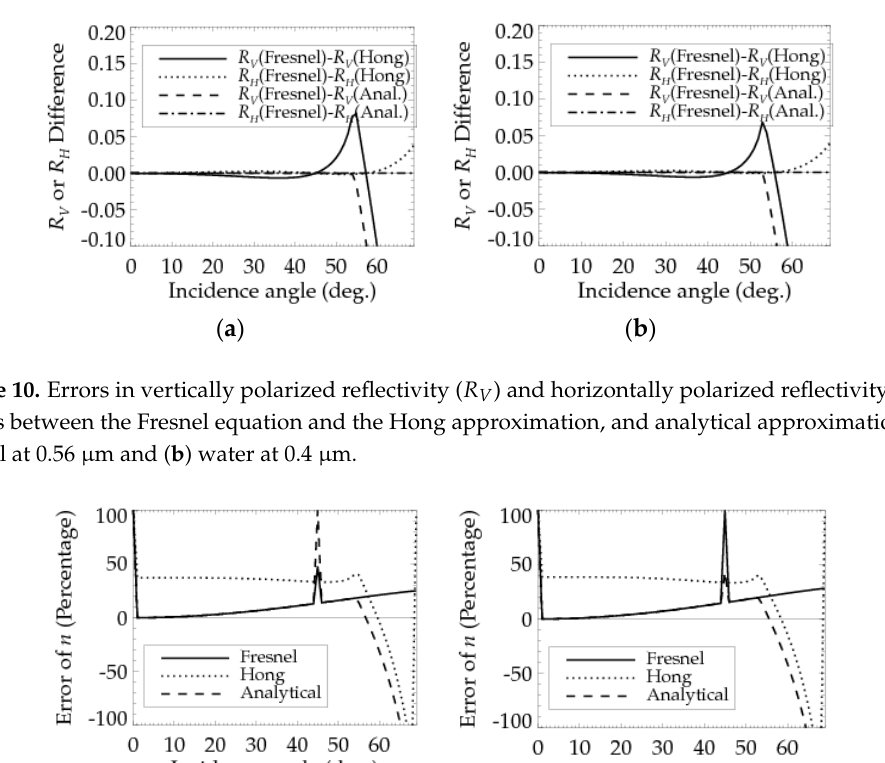
Figure 10. Errors in vertically polarized reflectivity ( (cid:1844) (cid:3023) ) and horizontally polarized reflectivity ( (cid:1844) (cid:3009) ) values between the Fresnel equation and the Hong approximation, and analytical approximation for ( a ) soil at 0.56 μ m and ( b ) water at 0.4 μ m.